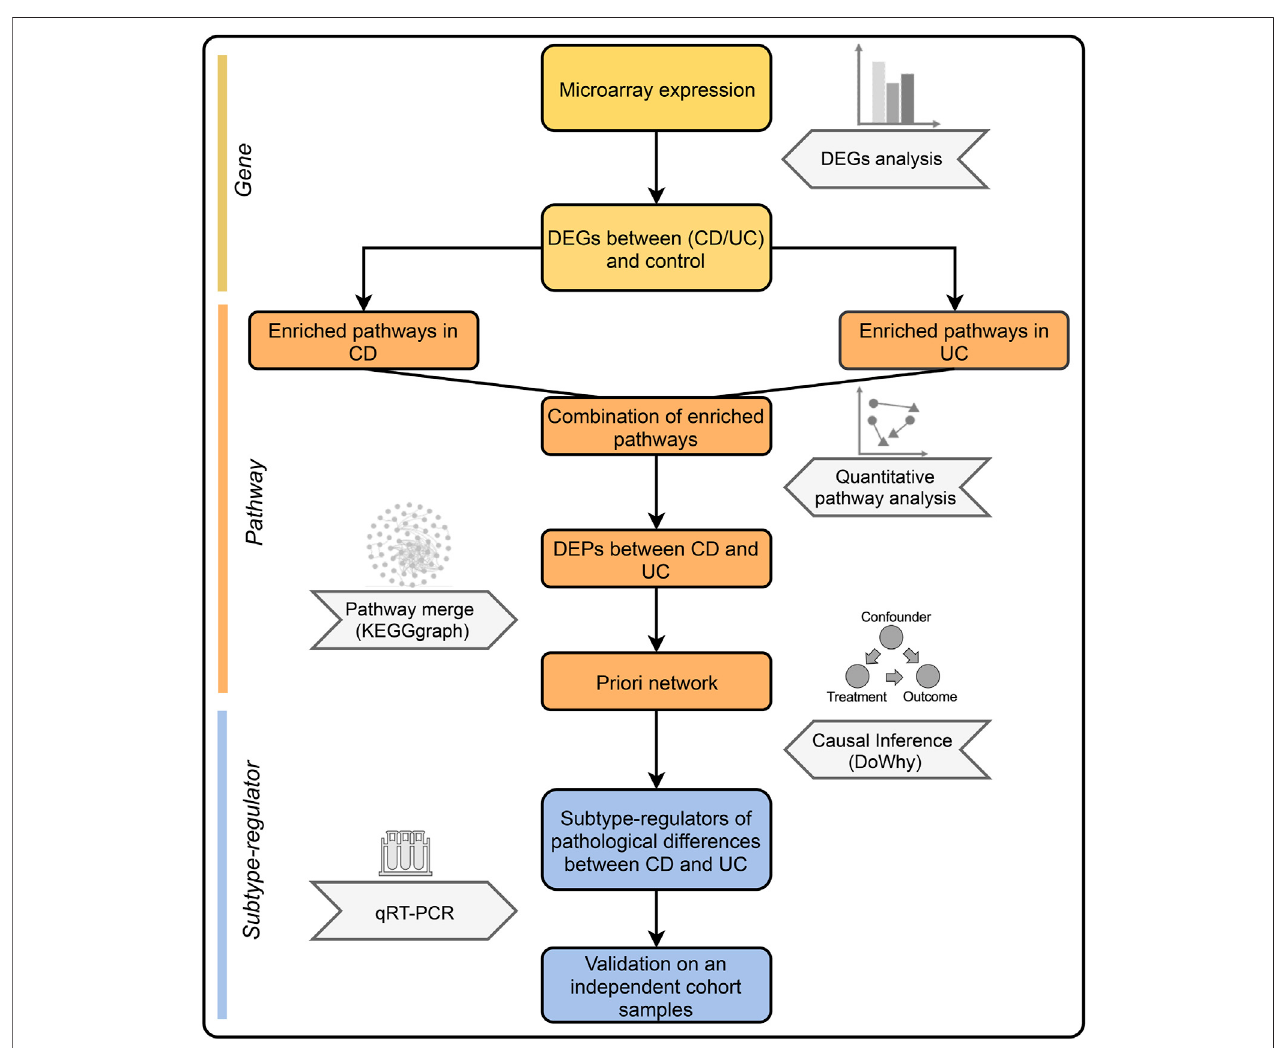
FIGURE 1 | Overall work fl ow of this study. First, DEGs between IBD and control groups were identi fi ed. Next, the combination of enriched pathways was compared between CD and UC by QPA to determine DEPs. Subsequently, DEPs were merged into a priori network, which was used to identify the subtype-regulators using causal inference. Finally, validation was performed by qRT-PCR with an independent